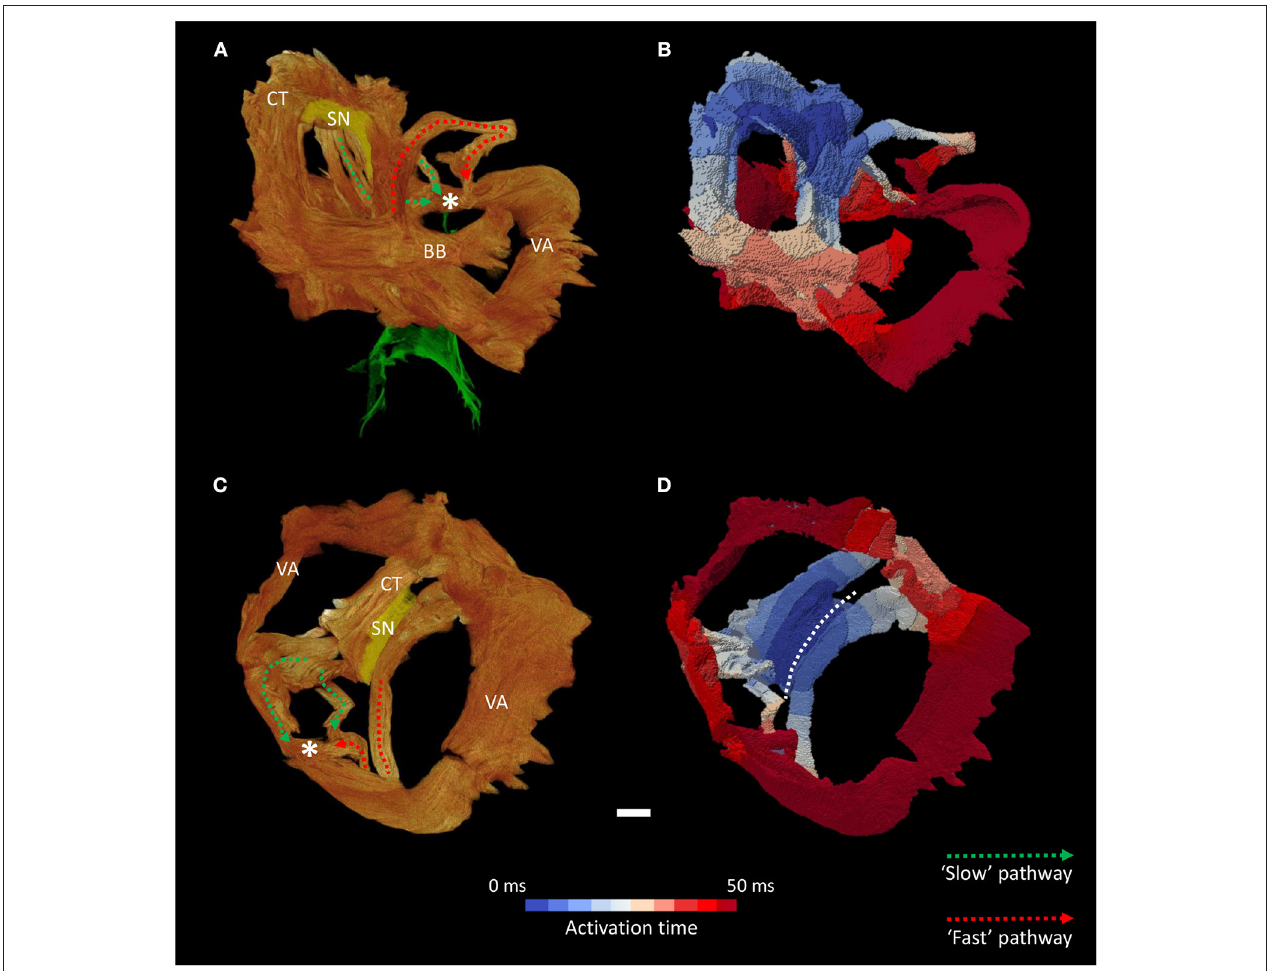
FIGURE 6 | Inter-nodal conduction through the atrial muscle bundles II. Volume renderings of the atrial muscle bundles in anterior (A) and inferior (C) views, the normal location and direction of the “slow” pathway (green), and the septal aspect of the elongated “fast” pathway (red) are indicated by dotted arrows. (B,D) Display the corresponding electrical activation maps, showing excitation of the distal aspect of the region normally associated with the “slow” pathway precedes that of the “fast” pathway. See methods for modeling parameters. *Location of compact atrioventricular node; BB, Bachmann’s bundle; CT, terminal crest; SN, sinus node; VA, valve annulus. Scale bar represents